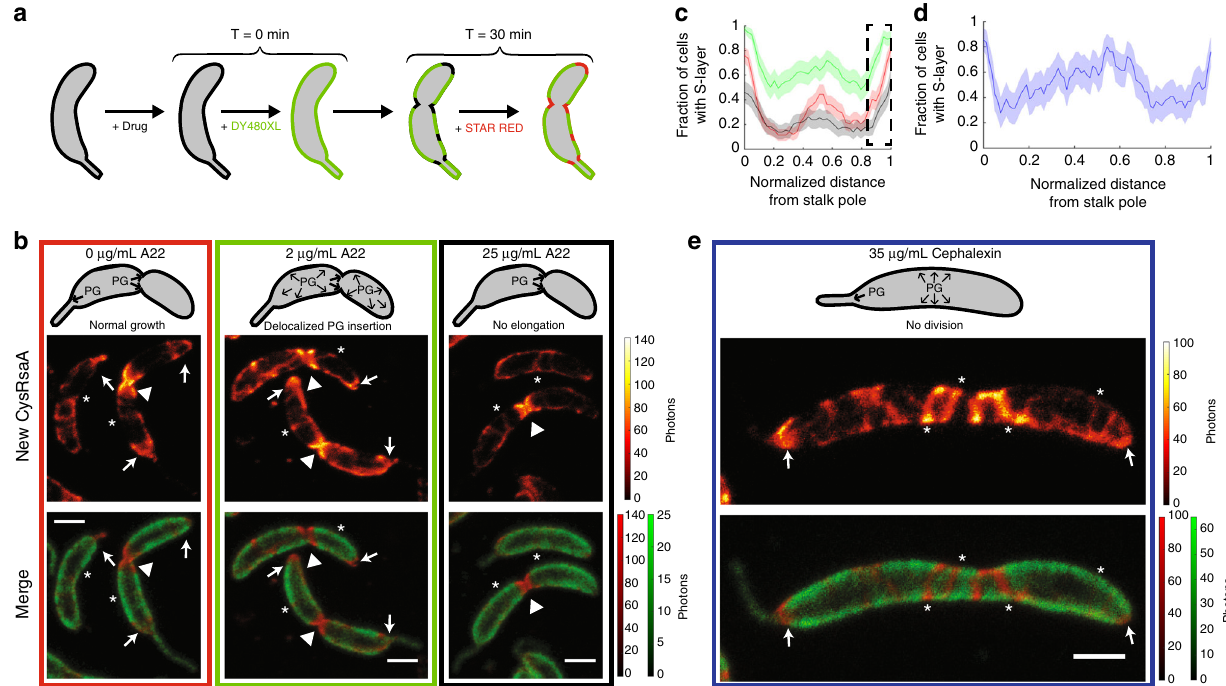
Fig. 2 Cell wall growth is insuf fi cient to explain polar localized S-layer assembly. a Schematic of pulse-chase labeling of CysRsaA cells treated with A22 (to inhibit MreB) for 1 h or cephalexin (to inhibit cell division) for 3 h. b Upper: Schematic showing effect of A22 treatment on PG insertion in C. crescentus , where untreated cells add PG primarily at the stalk pole and division plane, cells treated with 2 μ g/mL A22 exhibit delocalized PG insertion along the entire cell with enrichment at the division plane, and cells treated with 25 μ g/mL A22 have PG insertion exclusively at the division plane. Lower: STED images of S-layer assembly for treated cells with signal at the poles, division planes, and crack-like features marked by arrows, triangles, and asterisks, respectively. c Quantitation of S-layer assembly localization on cells treated with 2 μ g/mL A22 (green) show similar degrees of polar localization, but enhanced localization along the cell body compared to untreated cells (red curve; reproduced from Fig. 1j). Polar localized S-layer assembly is decreased in cells treated with 25 μ g/mL A22 (black), including the pole opposite the stalk (black dashed box). Shaded regions show 95% con fi dence intervals for n = 81, 54, and 63 cells for 0 μ g/mL, 2 μ g/mL, and 25 μ g/mL A22 treatment, respectively. d Quantitation of S-layer assembly localization on cells treated with 35 μ g/mL cephalexin show localization at both poles. Shaded region shows 95% con fi dence interval for n = 25 cells. e Upper: Schematic showing effect of 35 μ g/mL cephalexin, which halts PG insertion during cell division. Bottom: STED image of CysRsaA cell treated with cephalexin shows localized S-layer assembly at both poles (arrows) while also adding S-layer at crack-like features (asterisks) along the cell body. Scale bars = 1 μ of the observed puncta during the 15 min incubation. Adding 5 treated with 2.5 nM Cy3-CysRsaA to form sparse, immobile S- nM of exogenously puri fi ed and labeled DY-480XL CysRsaA fol- layer crystalline patches or seeds on the LPS outer membrane lowed by 10 nM of STAR RED CysRsaA revealed expansion of (Fig. 4a, green). Then, 1 nM AlexaFluor647-CysRsaA (Fig. 4a, fl uorescent puncta from the perimeter, as observed with two-color red) was added to the growth media, allowing single molecules to fl ow into the microscope ’ s viewing area. Once attached to the LPS native de novo S-layer assembly (Fig. 3e, h, i). These observations are consistent with each punctum representing a nucleated RsaA outer membrane, CysRsaA molecules were imaged for several minutes at a time (Fig. 4b). CysRsaA tracks included entirely